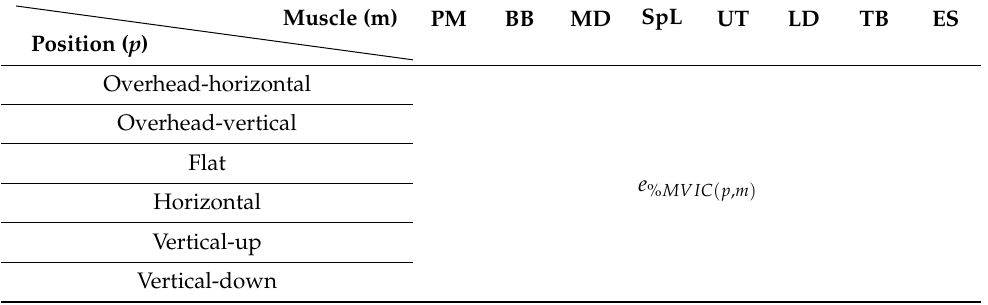
Table 7. Tabulated EMG values e % MVIC ( p , m ) for welding position p and muscle